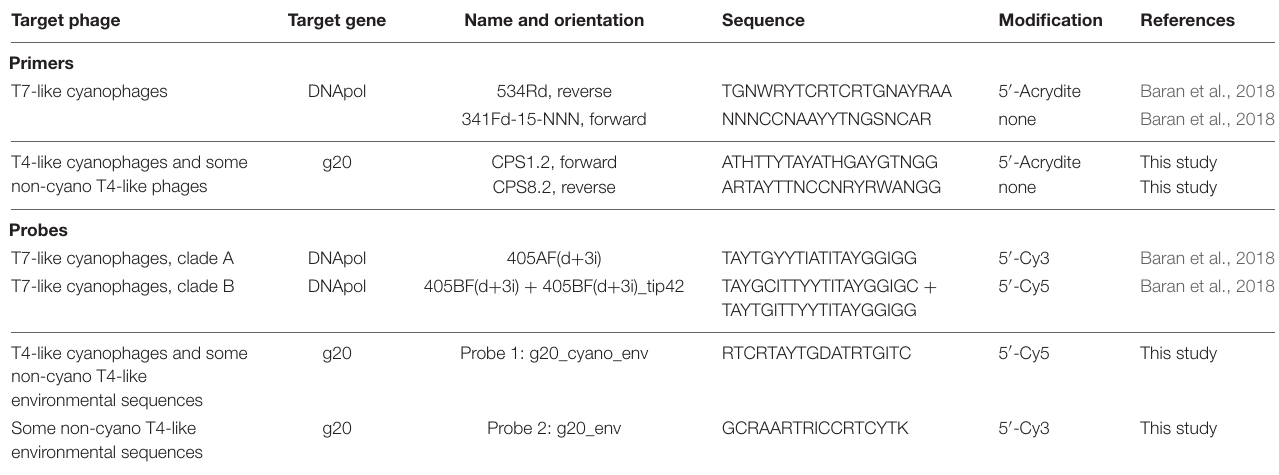
TABLE 1 | Primers and probes used in this